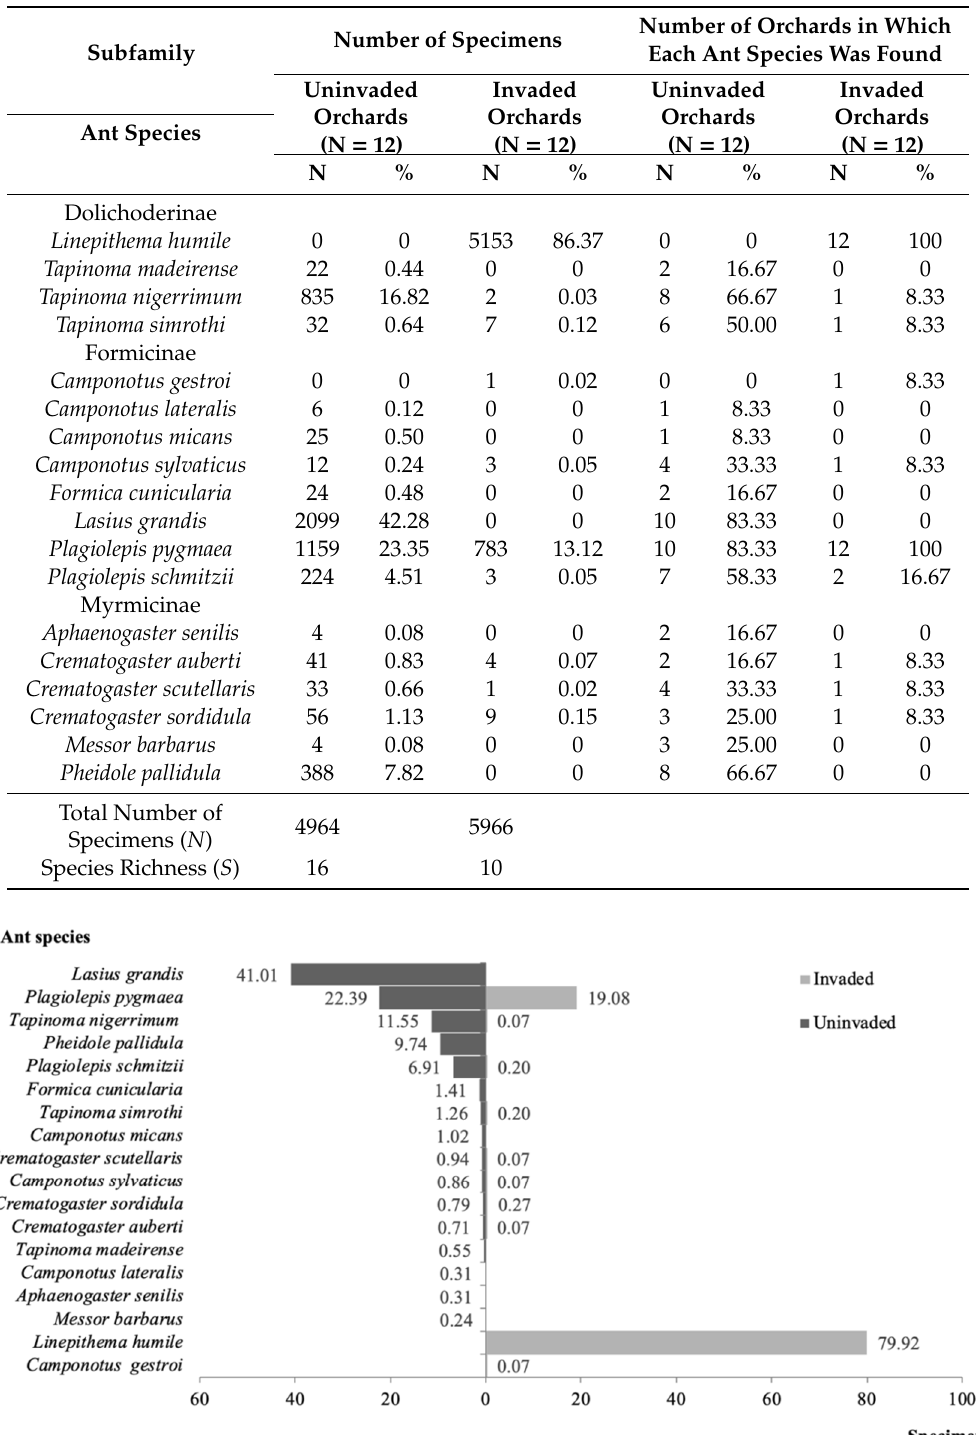
Table 1. AntspeciescollectedinArgentineantinvadedanduninvadedcitrusorchardsofAlgarve,Portugal.